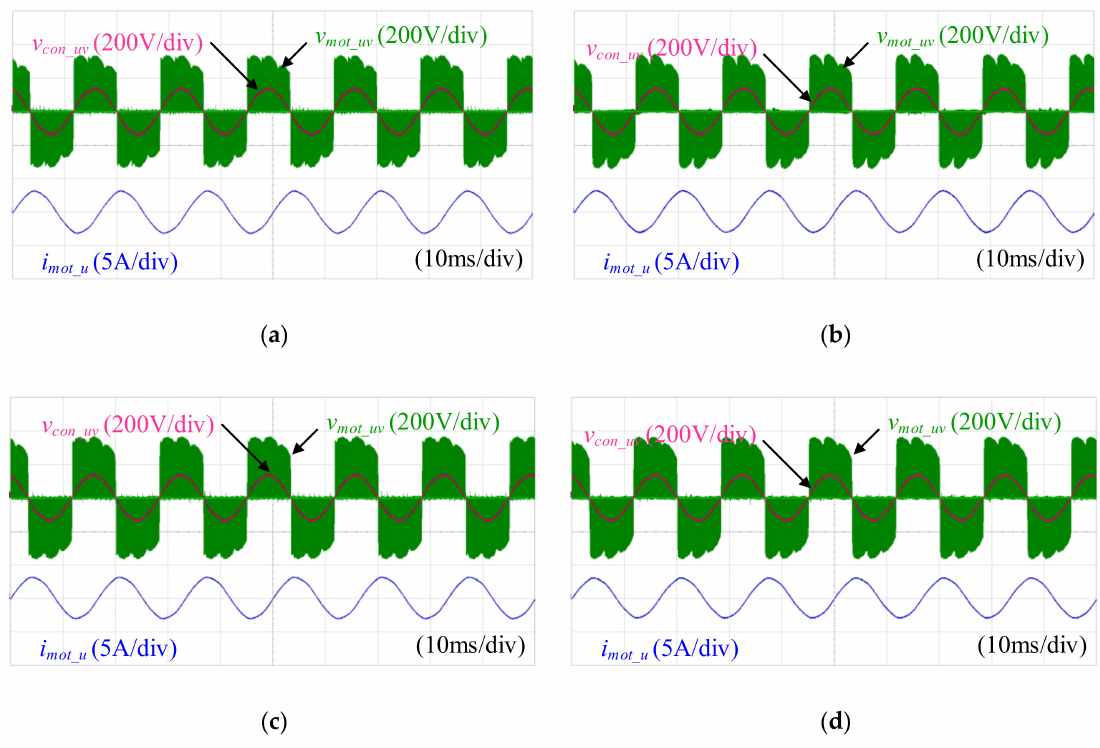
Figure 11. Experimental results of GaN-based VFD with two sets of sine wave filter; ( a ) 5-m cable length, with sine filter ( L f = 250 µ H, C f = 2.2 µ F); ( b ) 25-m cable length, with sine filter ( L f = 250 µ H, C f = 2.2 µ F); ( c ) 5-m cable length, with sine filter ( L f = 117 µ H, C f = 4.7 µ F); ( d ) 25-m cable